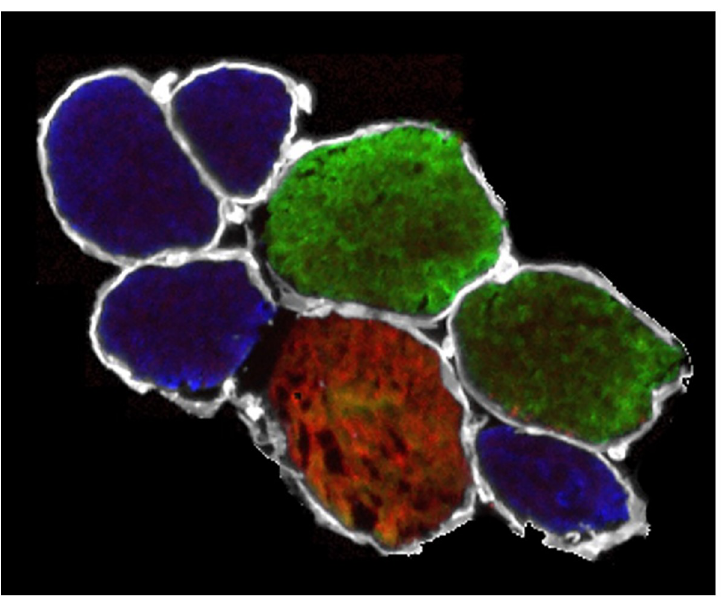
Fig 4. Cross cryo-section of a bundle. Cross cryo-section of a bundle not exposed to skinning procedure and mechanical experiment. White colour refers to laminin, blue to slow fibres, green to fast 2A fibres and red to fast 2X